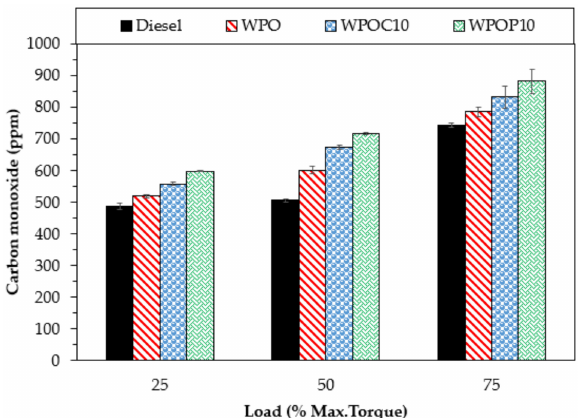
Figure 8. Carbon monoxide emissions.